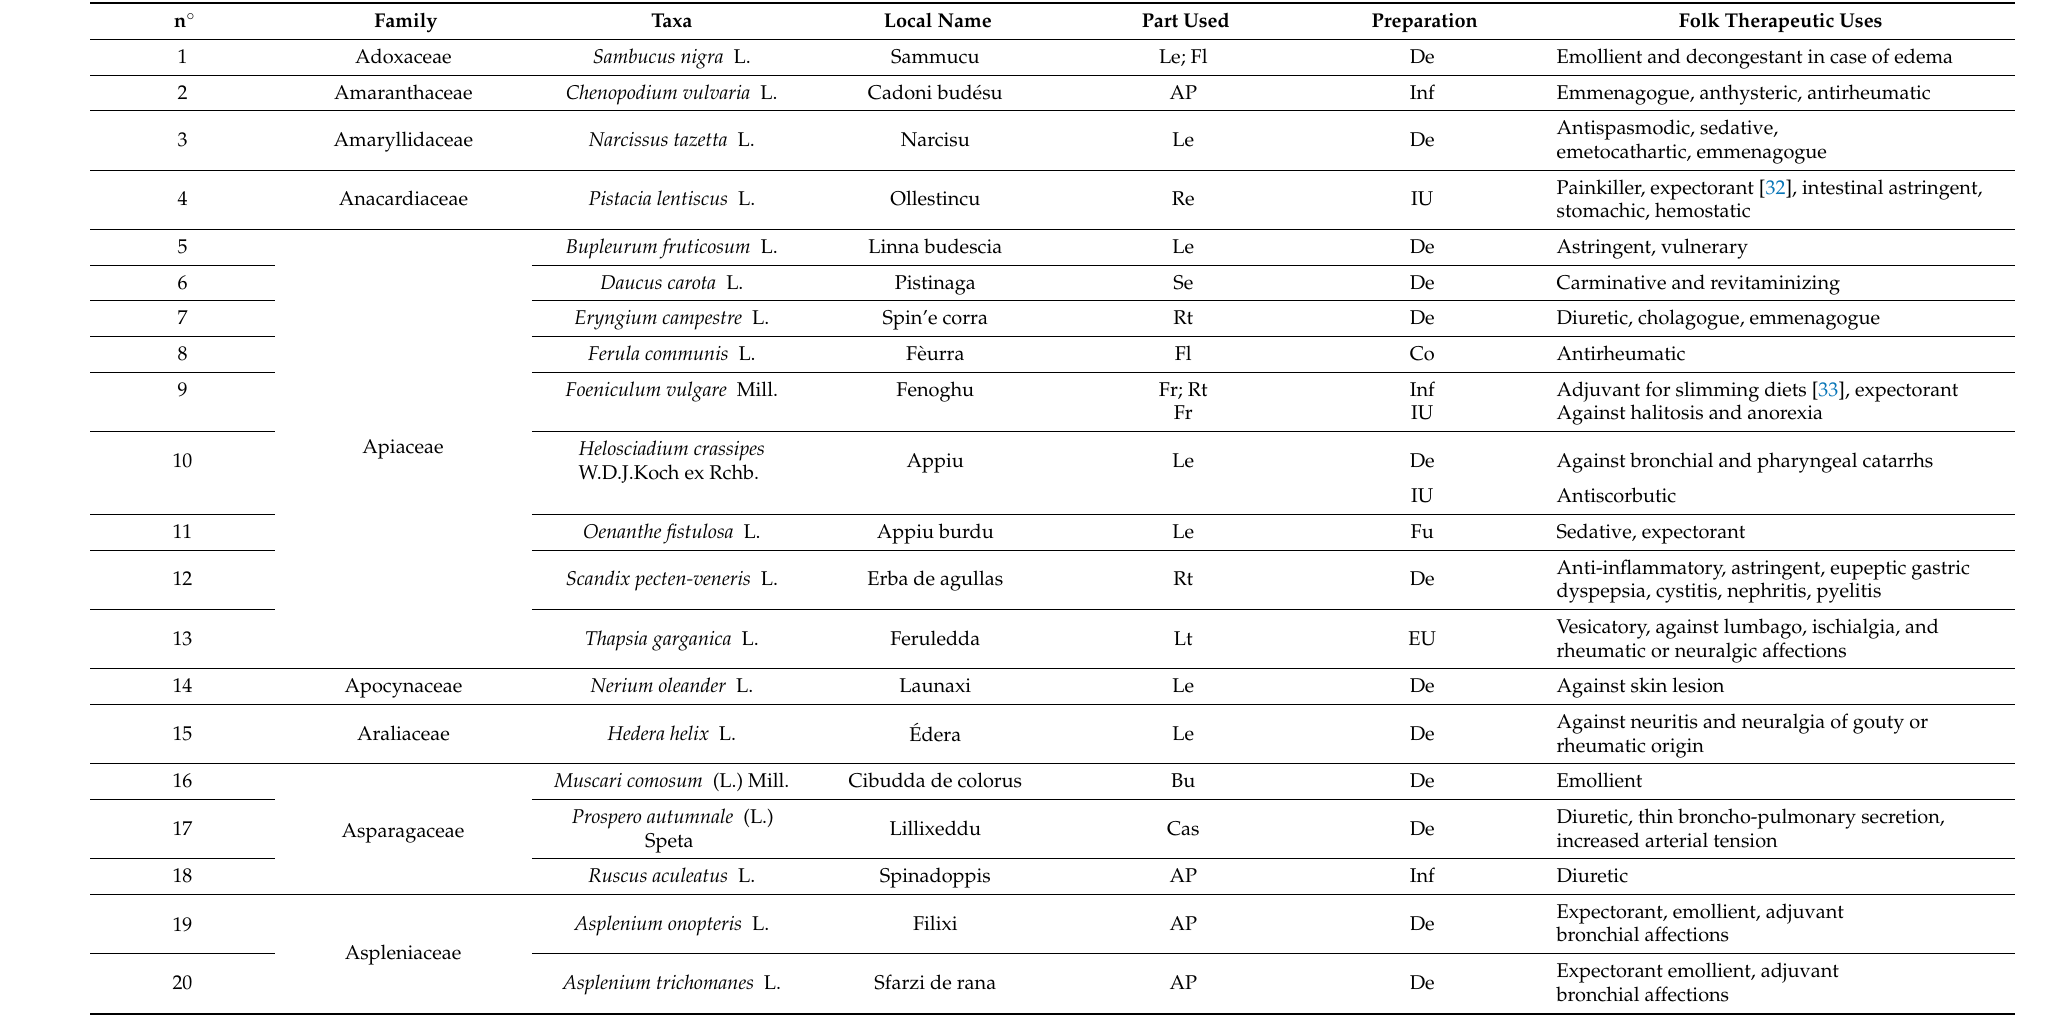
Table 1. List of the emerged species: scientific and local name, part of the plant used, preparation, and Folk therapeutic